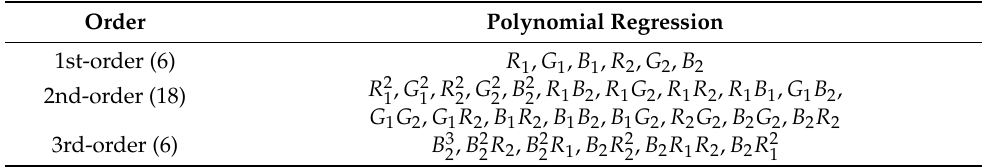
Figure 5. Feature selection among 84 items. ( a ) Feature weight of 84 extended feature items. ( b ) Hierarchical treemap view of feature weights. Table 1. Selected terms of the polynomial